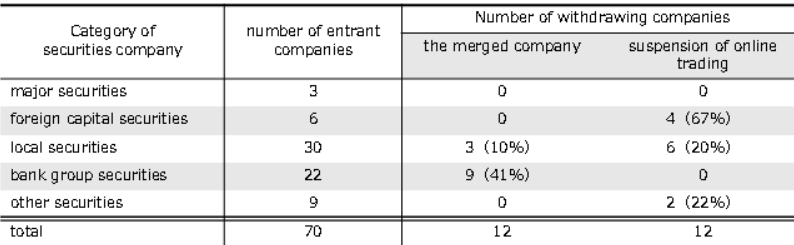
Table 2. Entry and withdrawal of five